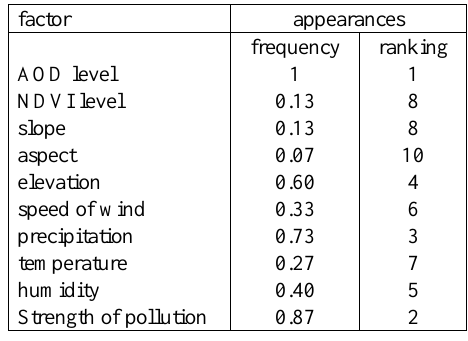
Table 1. Appearances of factors in reduction sets 15 reduction sets were retrieved by rough set analysis.